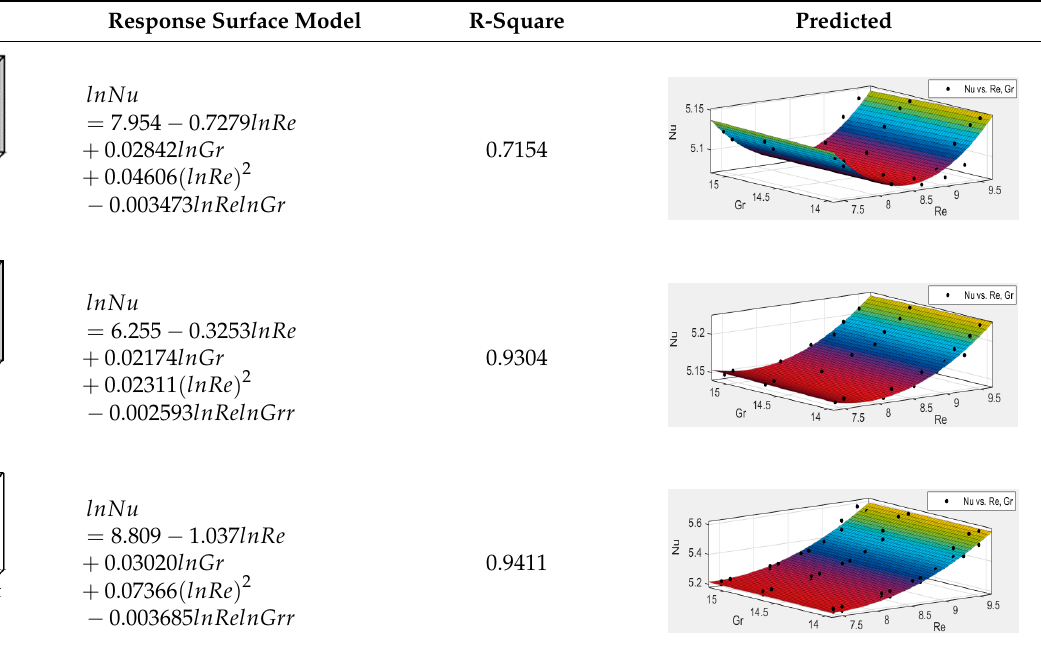
Table 5. RSM fitting formulas under the 30° and 45° wind direction condition.